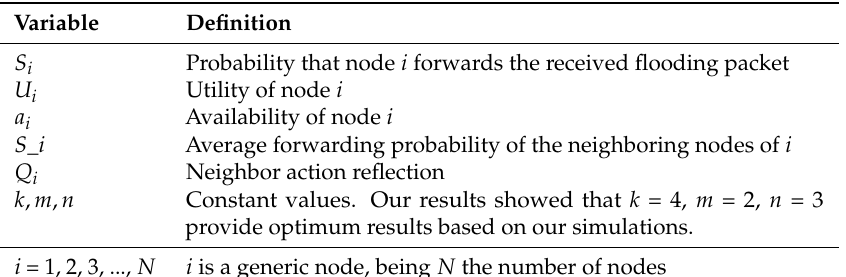
Table 2. Definitions of the variables presented in the Forwarding